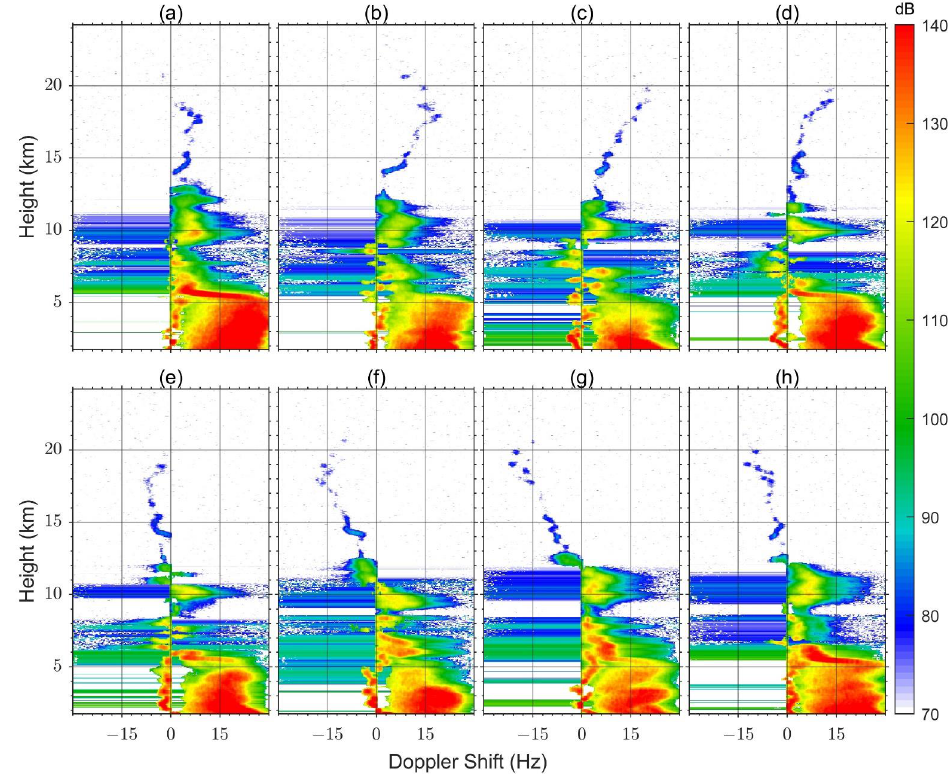
Figure 11. Echo power spectrum during rainfall corresponding to the eight azimuths of 0° (( a ) north), 45° (( b ) northeast), 90° (( c ) east), 135° (( d ) southeast), 180° (( e ) south), 225° (( f ) southwest), 270° (( g ) west), and 315° (( h ) northwest) with a zenith angle of 15°. The unit is dB, and the experi- ment time is 15:00 local time on 17 July 2021.